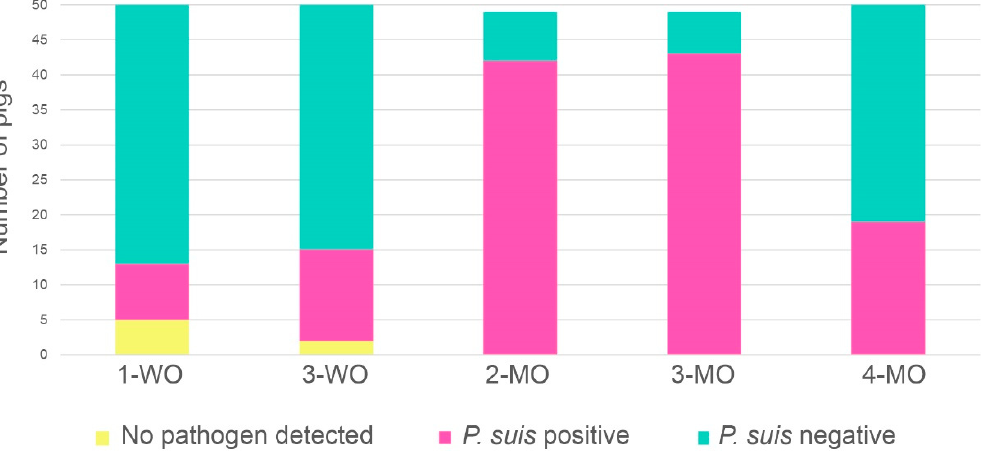
Figure 2. Overall P. suis prevalence over time. P. suis positive pigs ( P. suis single-infections and co-infections with P. suis and other pathogens) are shown in pink, P. suis negative pigs (positive for other pathogens) are shown in turquoise and pigs without any pathogen detected are shown in yellow.